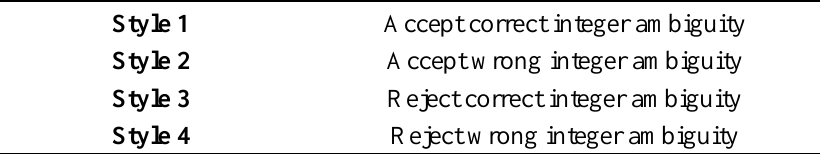
Table 5. Ambiguity resolution results